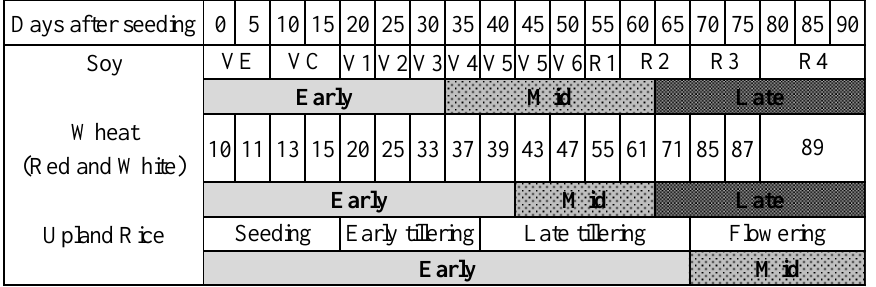
Figure 1. Phenological aggregation into three classes for the species considered in this study. For each species, the top line reports the observed crop growth stage recorded using commonly used growth stage identification protocols. Growth phases and durations, outlined by Arraudeau and Vergara [48], were used for identifying phenological stages of upland rice. The soy was identified using the protocol outlined by Pedersen et al. [49]. Both red and white varieties of wheat followed the Zadok’s code [50]. The bottom row of each species row reports the phenological aggregation.